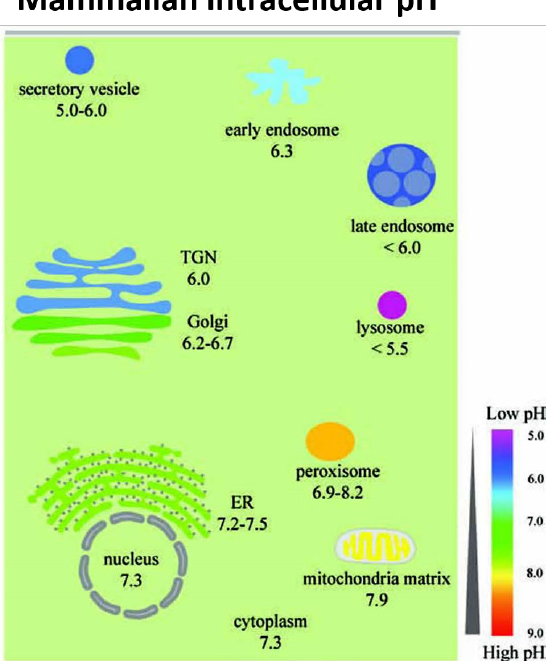
Figure 2. The range of pH values in intracellular compartments is shown schematically. The extent and type of chemical activity of metal oxide NPs may vary significantly, even in a single cell, across a wide range of pH values in different organelles. ER, endoplasmic reticulum and TGN, trans -Golgi network. From Shen et al. [41] with